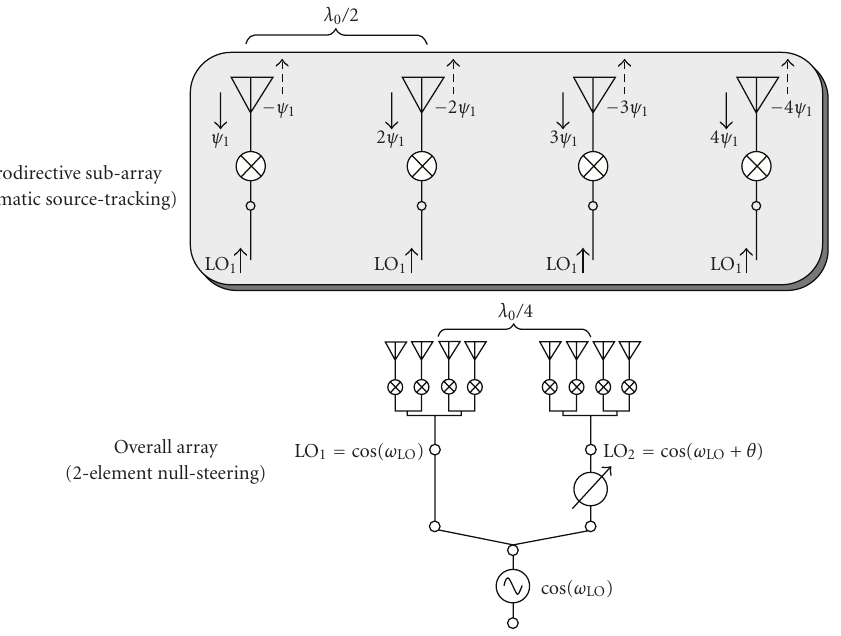
Figure 10: Schematic of interleaved retrodirective subarray